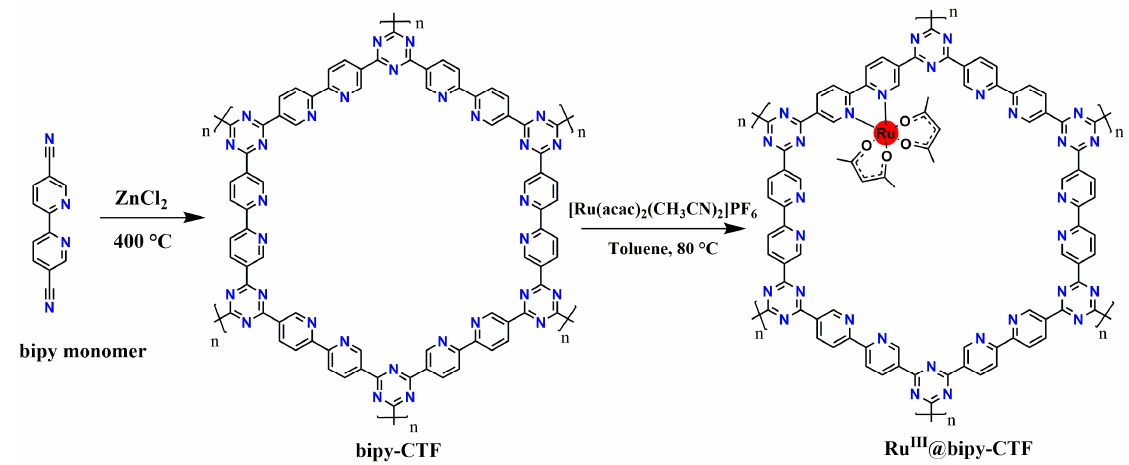
Figure 1. Schematic representation of the ideal ordered structure of Ru III @bipy-covalent triazine framework (CTF) material.